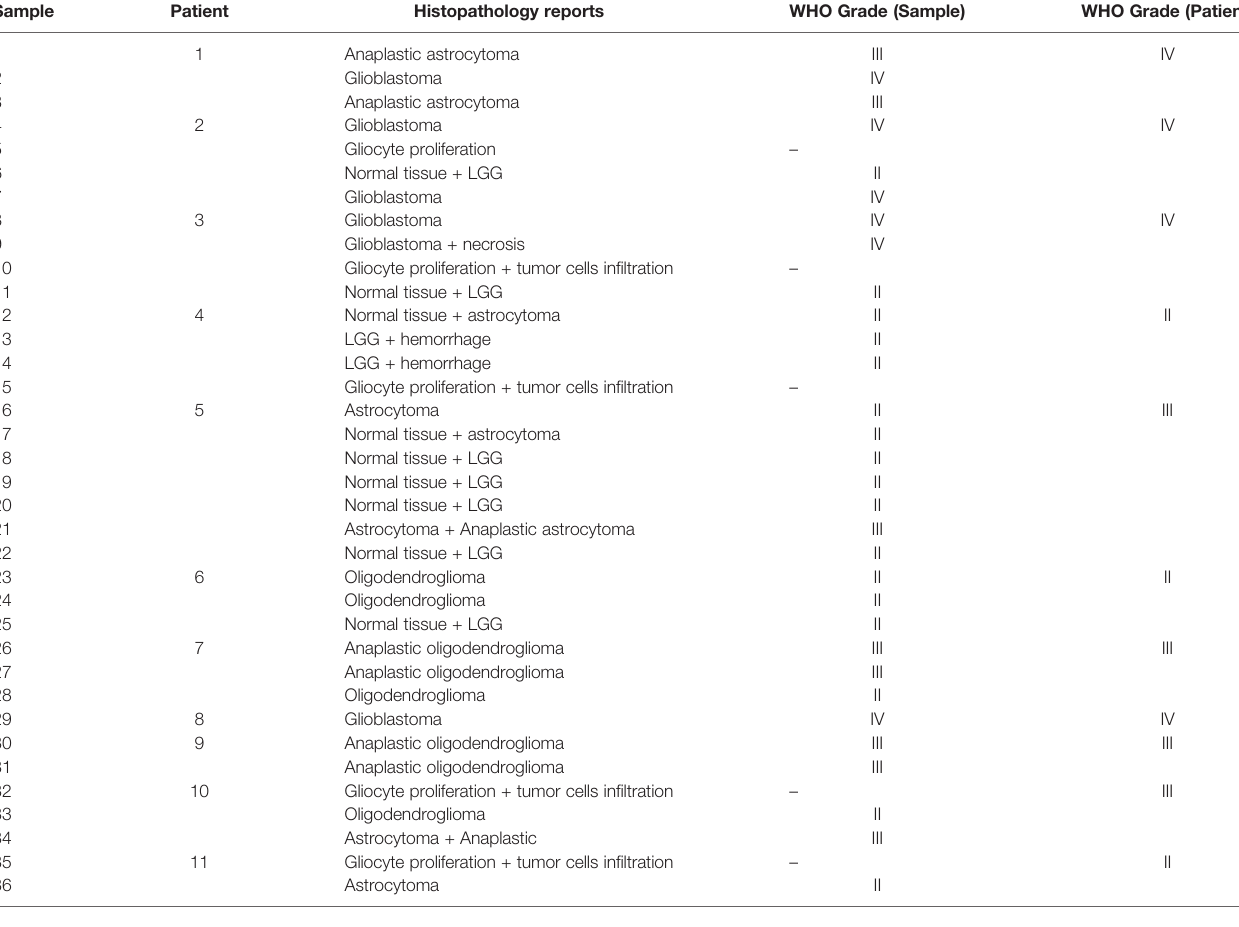
TABLE 1 | Histopathology results of each biopsy site and patient. Sample